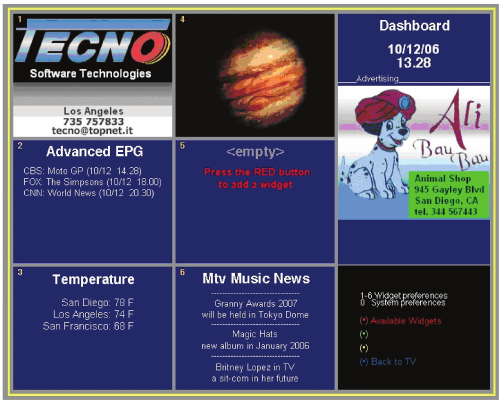
Figure 9: A Screenshot of the dashboard application.